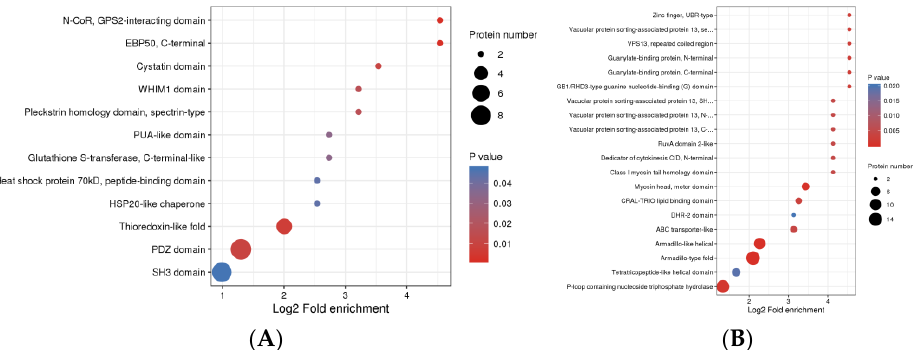
Figure 5. The top 25 protein domain enrichment analysis of DPPs. ( A ) The protein domain enrichment analysis of up-regulated DPPs. ( B ) The protein domain enrichment analysis of down-regulated DPPs. The x − axis is the Log2-fold enrichment, and the y − axis is the protein domains. The bubble size indicates the number of DPPs, and the color indicates the p value.